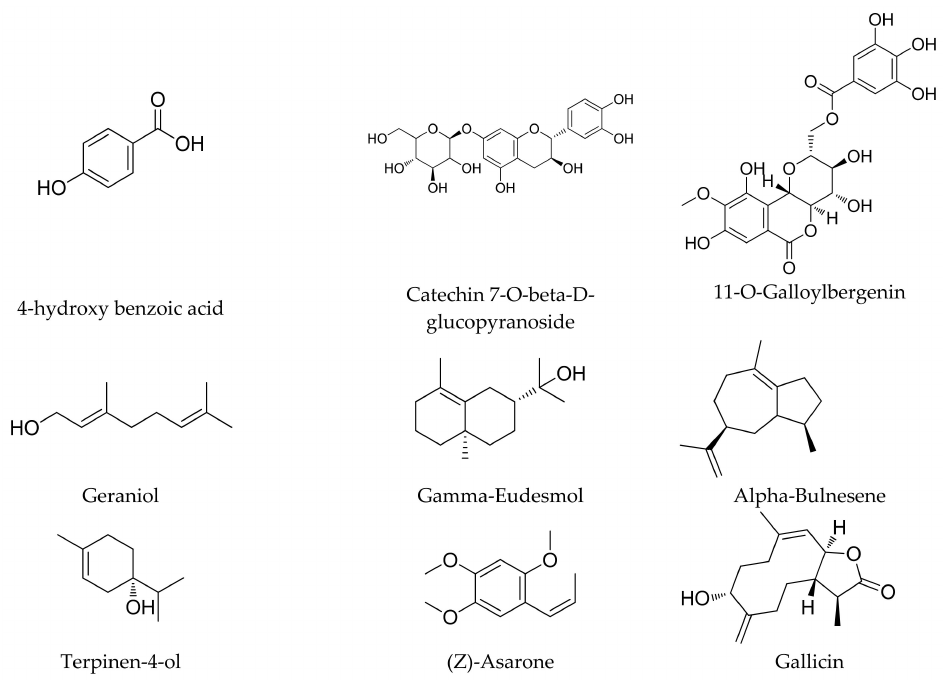
Figure 3. Phytochemicals present in Bergenia pacumbis (Buch.-Ham. ex D.Don) C.Y.Wu &